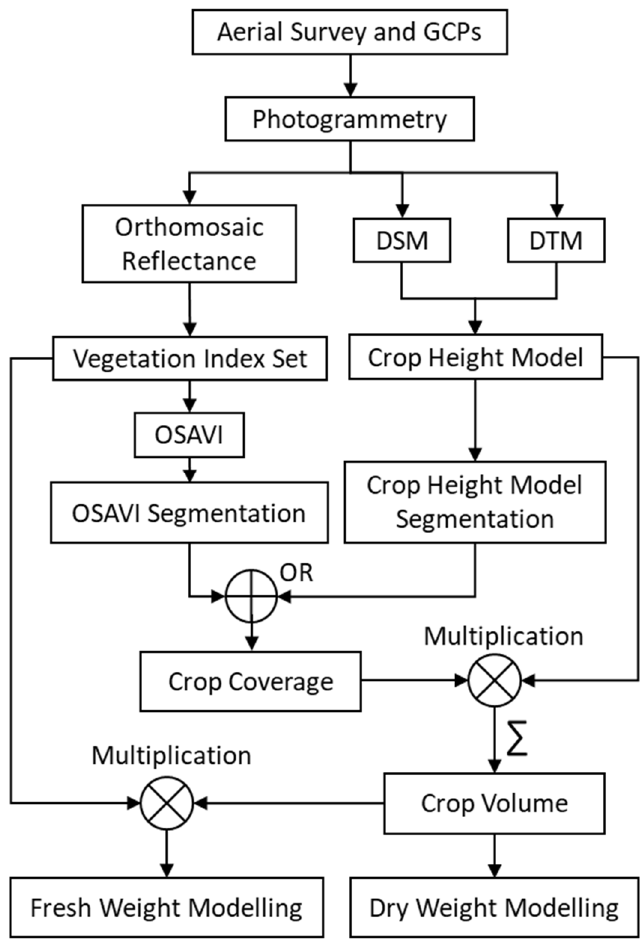
Figure 2. The processing workflow used for: Modelling—dry weight and fresh weight; Computing intermediate traits—crop height model, crop coverage and crop volume; Using—vegetation index, digital surface model (DSM) and digital terrain model (DTM).